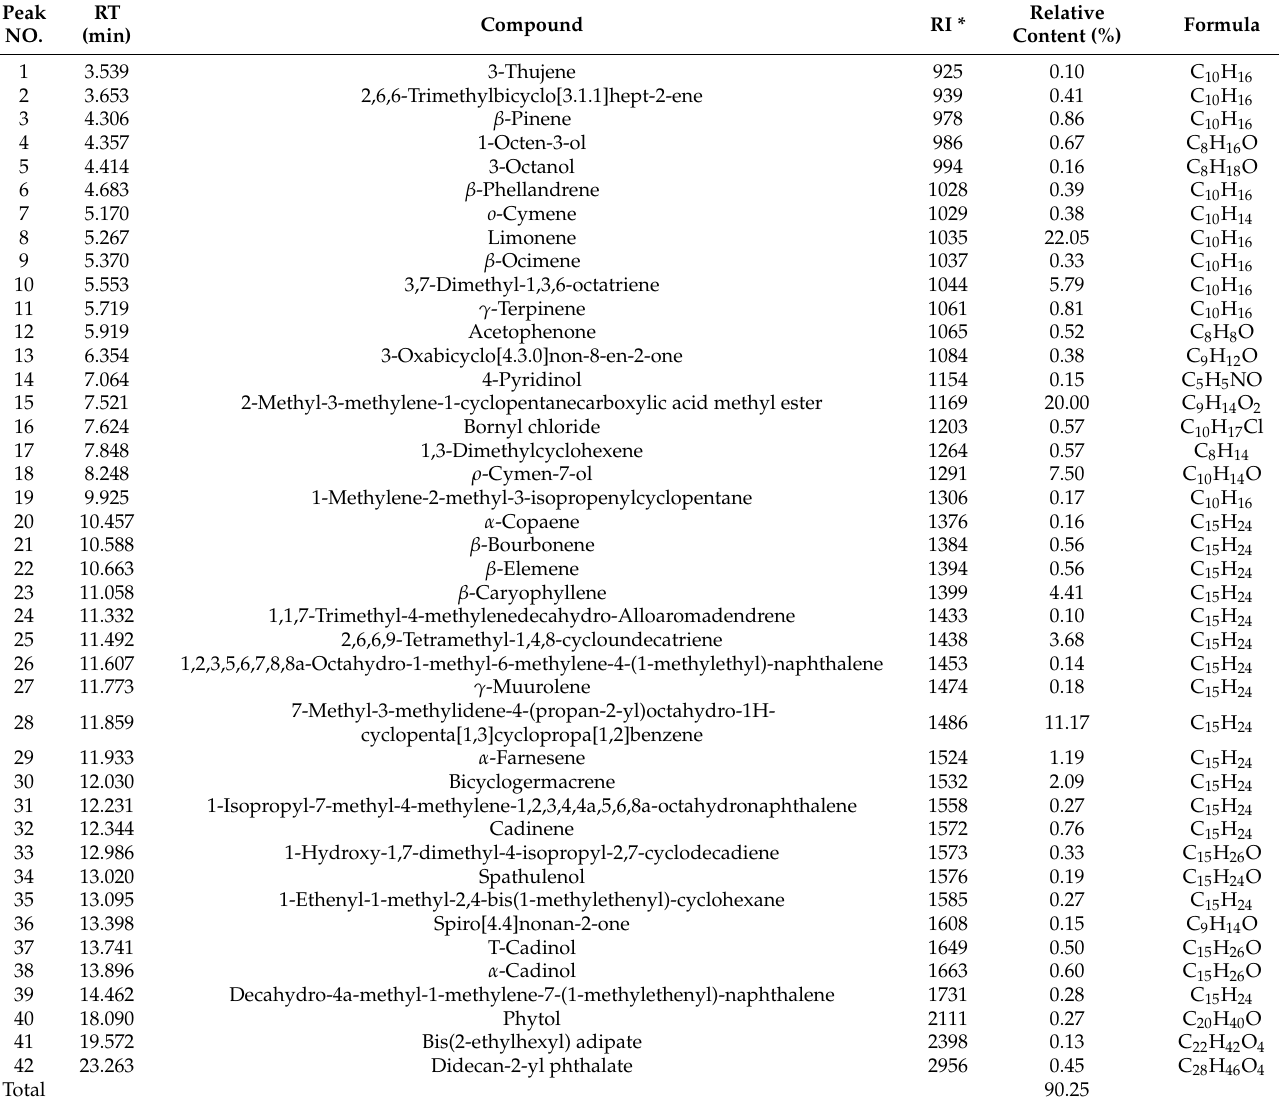
Table 3. Chemical composition of essential oil from the E. densa.